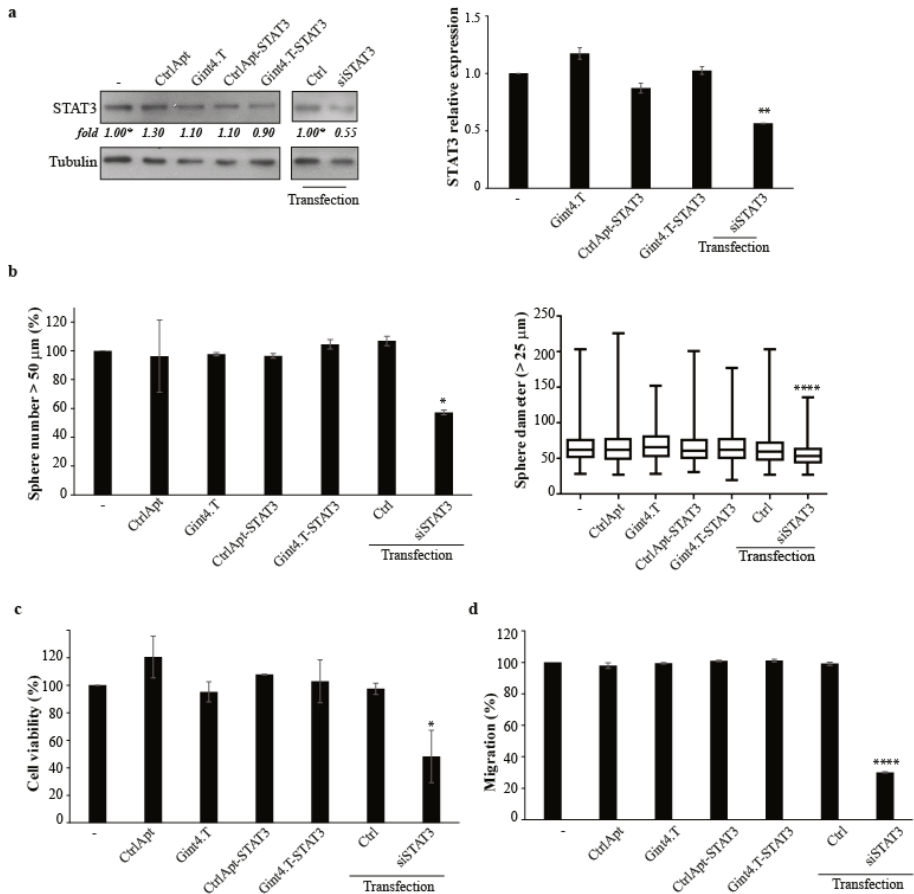
Figure 5. Gint4.T-STAT3 specificity. ( a ) GSC#144 (PDGFR β − ) were left untreated ( − ), treated with indicated aptamer or conjugates (400 nmol / L), or transfected with siSTAT3 (100 nmol / L) for 72 h, as indicated. Left panel: Cell lysates were immunoblotted with anti-STAT3 and anti-tubulin (used as a loading control) antibodies. Values below the blots indicate quantization relative to the control samples (labelled with asterisks) normalized on the loading control signals. Right panel: STAT3 mRNA levels were measured by RT-qPCR. Vertical bars indicate the mean ± SD ( n = 2). ( b ) Sphere formation of GSC#144 (PDGFR β − ) left untreated ( − ), treated, or transfected, as indicated. Left panel: Spheres with a diameter > 50 µ m were counted and expressed as the percentage relative to the untreated samples ( − ), set to 100%. Mean ± SD ( n = 2) is reported. Right panel: Boxplot representation of diameter measures (spheres with a diameter > 25 µ m). ( c ) Cell viability of GSC#144 (PDGFR β − ) following 72 h of indicated treatment (400 nmol / L) or transfection (100 nmol / L). Vertical bars: Mean ± SD ( n = 2). ( d ) Cell migration of GSC#144 (PDGFR β − ) following 24 h of indicated treatment (400 nmol / L) or transfection (100 nmol / L). Vertical bars: Mean ± SD ( n = 3). In ( c , d ), results are expressed as percentages with respect to the untreated cells. In ( a – d ), the statistics were obtained by one-way ANOVA: *, p < 0.05; **, p < 0.01; ****, p < 0.0001. Whole blots of Figure 5a are shown in Figure S8.